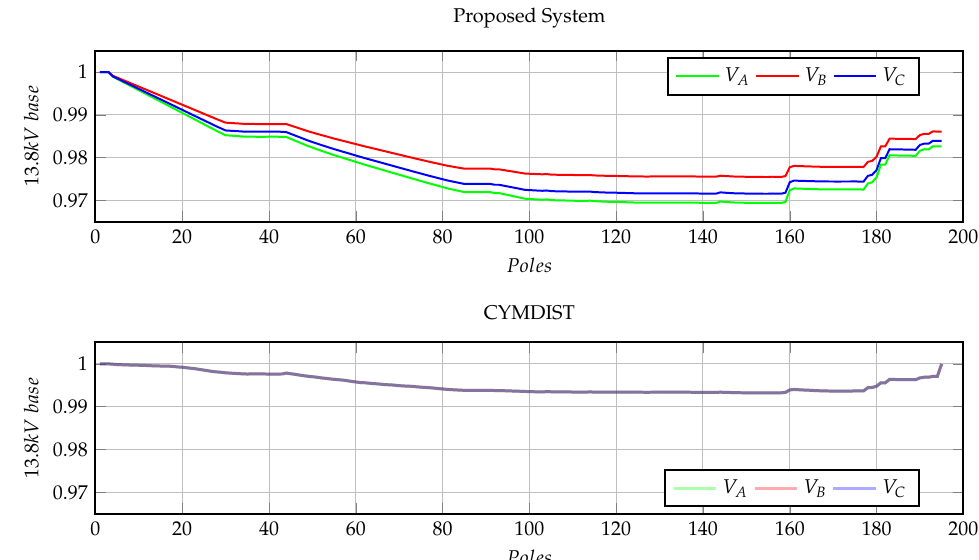
Figure 7. Visualization of the overlapping of the phase voltages V A , V B and V C in the Proposed System ×